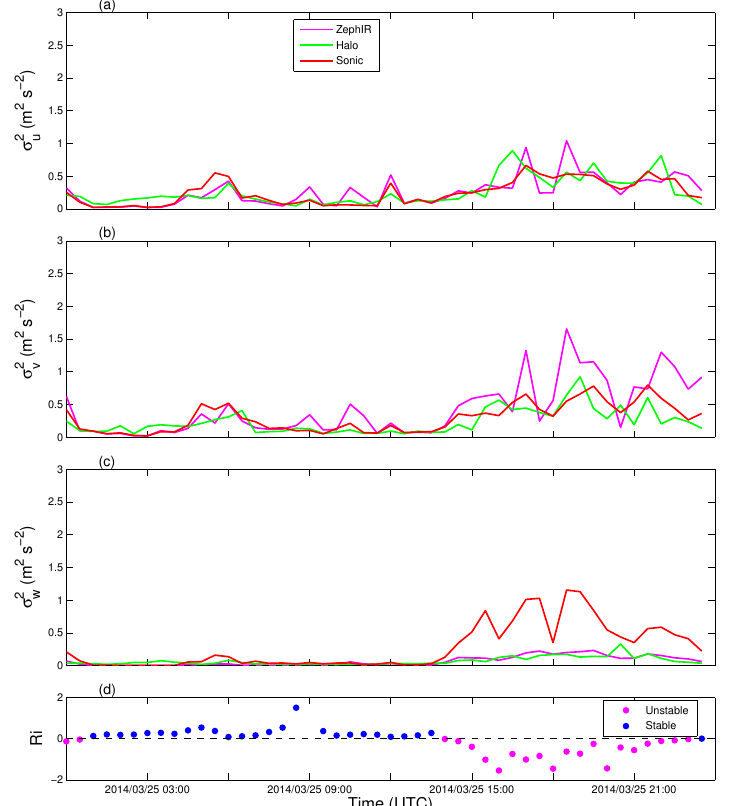
Figure 5. 30min (a) u variance, (b) v variance, and (c) w variance at 100m from sonic anemometers and lidar VAD techniques at BAO and (d) Richardson number calculated from tower data. Data are shown from 25 March 2014. Comparison of the Halo and ZephIR VAD- processed data suggests that a lower elevation angle may be advantageous (e.g., lower v variance values measured by the Halo lidar, which uses a lower elevation angle, shown in b ). Note the smaller u and v variance values shown here for the Halo and ZephIR (VAD) as compared to the Wind Cube (DBS) in Fig.